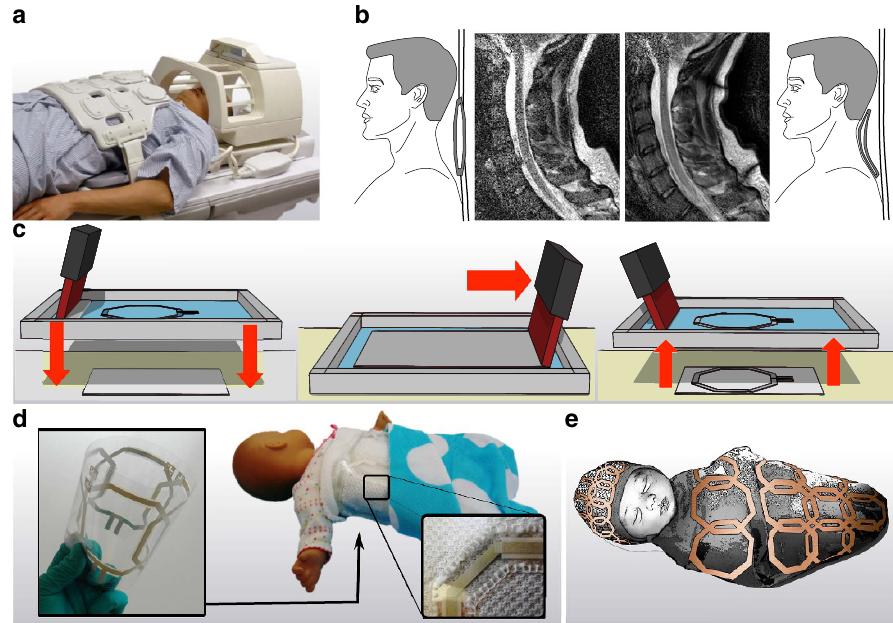
Figure 1 | RF receive coil arrays proximity to body results in better image SNR. ( a ) Conventional MRI receive arrays on the chest and head of a patient. ( b ) Cervical spine images of volunteer showing low-SNR when using a coil placed 8cm away from the spine (left) and high SNR when placed against the skin (right). ( c ) Schematic representation of fabrication process of flexible printed coils. The screen is patterned with emulsion (blue) and shows the coil design. Ink (grey) is transferred to the substrate (white) during the screen-printing process. ( d ) Photograph of a printed flexible four-channel coil array fabricated on plastic film and integrated into an infant blanket. The inset shows how a printed coil is stitched into the fabric. ( e ) Concept drawing of an infant swaddle and hat with an integrated printed receive coil array.